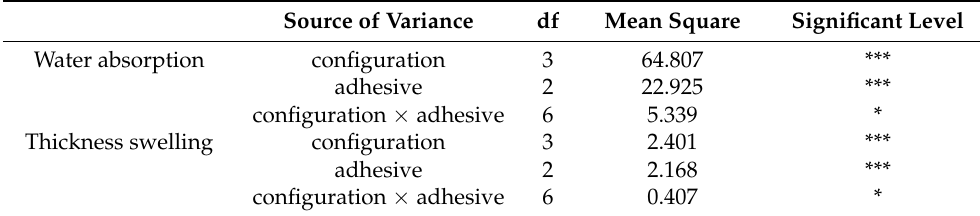
Table 4. ANOVA results of dimensional stability. Source of Variance df Mean Square Water